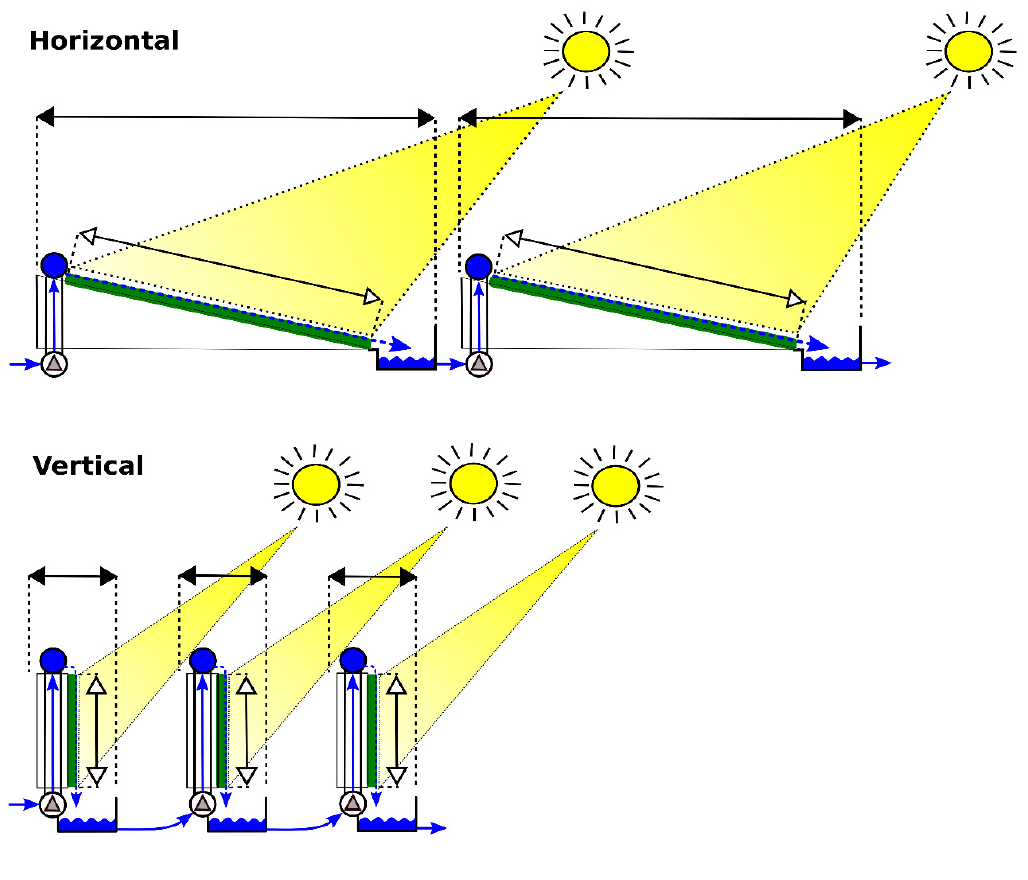
Figure 4. Design of microalgal biofilm modules supplied with wastewater depicting a concrete-based biofilm system for P removal (Horizontal) with a rectangular concrete cultivation area, and a geotextile-based biofilm system for P removal (Vertical) with a geotextile cultivation area mounted on a rectangular frame.